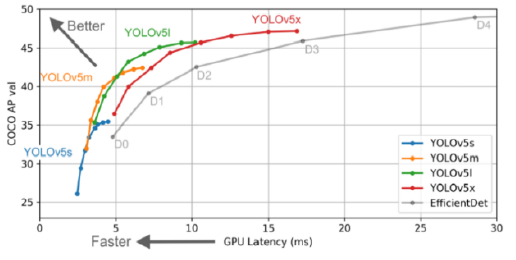
Fig. 3. Accuracy of YOLOv5 compared to other YOLO